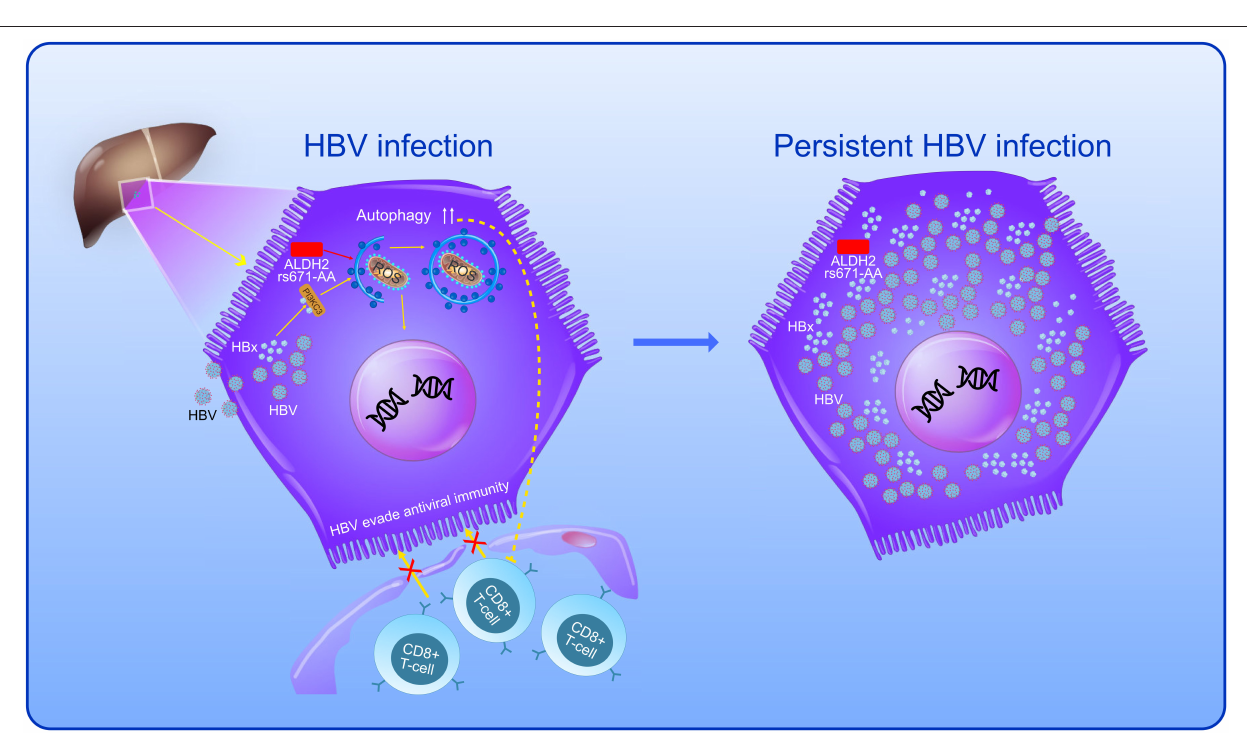
FIGURE 3 | The possible hazardous role of the rs671-AA variant during HBV infection and persistence. The autophagic pathway in HBV-infected hepatocytes is enhanced by hepatitis B virus × protein (HBx) via the binding to phosphatidylinositol 3-kinase class III (PI3KC3). Meanwhile, ALDH2-rs671-AA mutant in individuals with decreased activity of ALDH2 enzymes might also activate the autophagy signal pathway, triggering autophagy then promoting HBV to evade antiviral immunity, permitting the survival of virus-infected hepatocytes, further enhancing the HBV replication and ultimately promoting the persistence of HBV